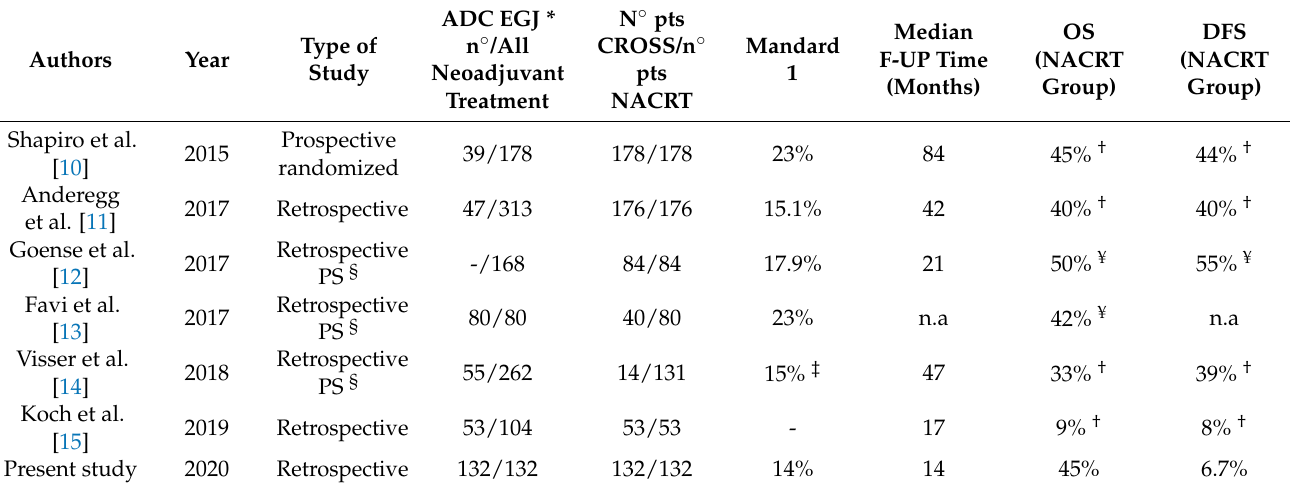
Table 4. Recurrence pattern according to yp stage.